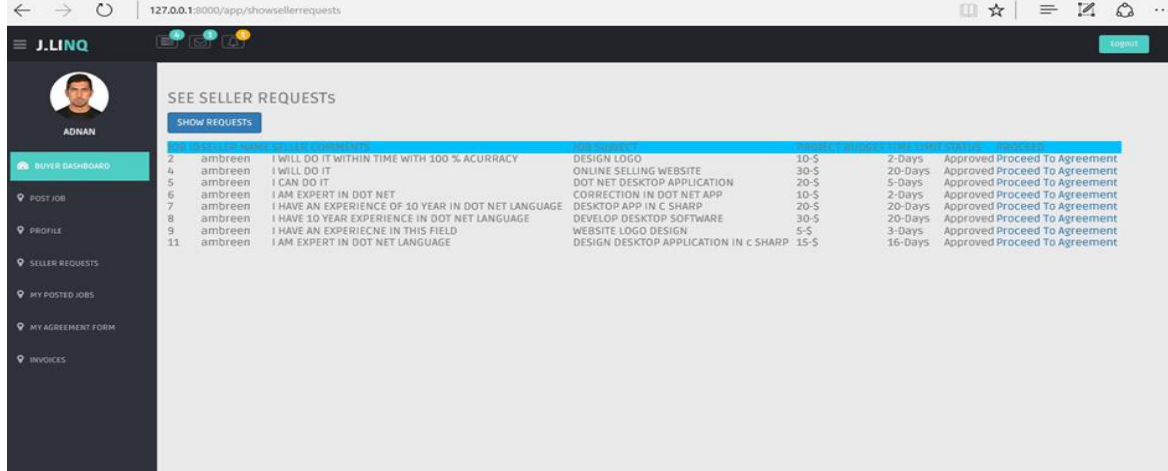
Figure 16. A bids review interface where bids are placed on jobs posted by the buyer.